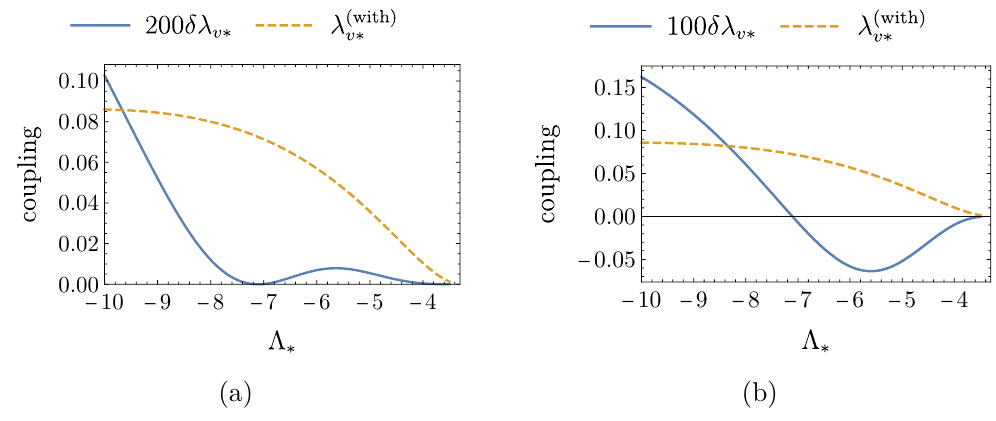
Figure 5 . Difference δλ v ∗ = λ (without) v ∗ − λ (with) v ∗ of the quartic coupling λ v without and with a dark sector for varying fixed-point values of the cosmological constant Λ at fixed Newton coupling ∗ , while G ∗ = 4 . 55 , i.e., in a gravitational scan. (a) λ ( without ) v ∗ is computed by setting λ HP = 0 in β λ v all other couplings are set to their λ -dependent fixed-point values. The direct contribution ∼ λ 2 HP HP lowers λ , causing δλ 0 . (b) λ ( without ) is computed by solving the full matter beta functions v ∗ v ∗ v ∗ > self-consistently. Negative λ 0 implies negative δλ 0 HP < v ∗ <